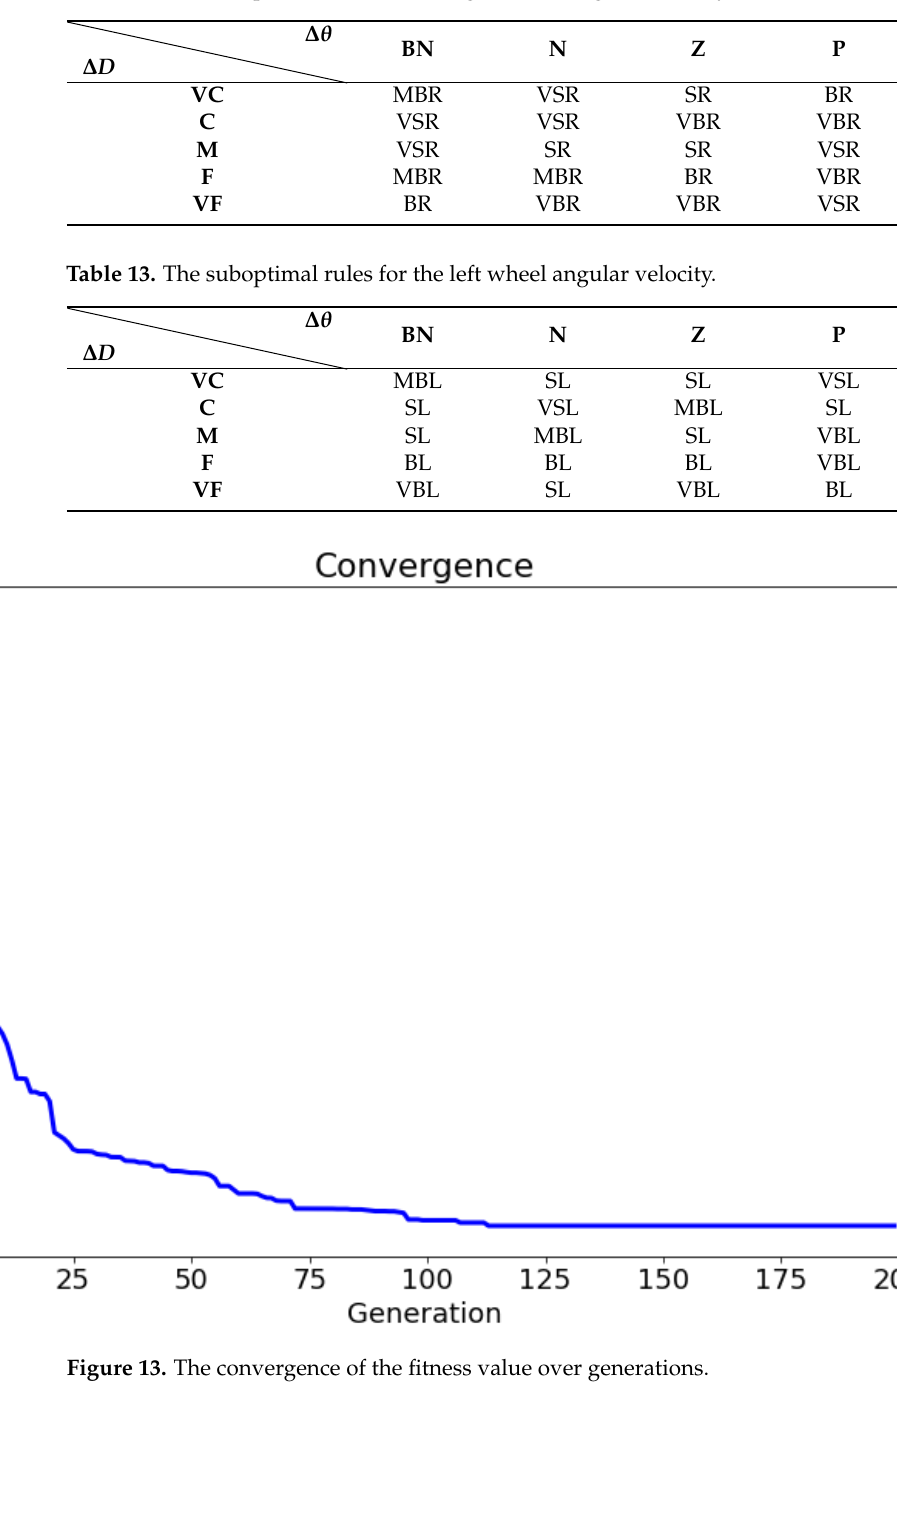
Table 12. The suboptimal rules for the right wheel angular velocity.